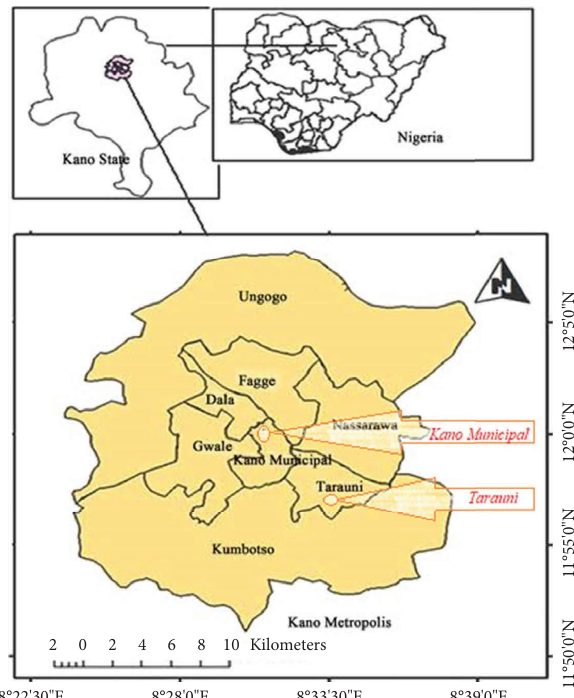
Figure 1: Map of Kano State showing the sampling site “Kano Municipal City and Tarauni Local Government” and states with which Kano shares boundary with